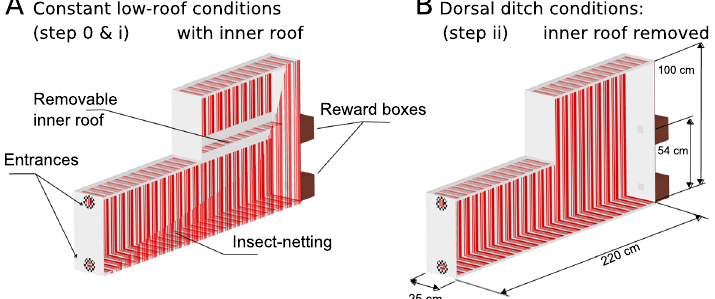
Figure 3. Perspective view of the double-roofed flight tunnel. The floor, roof and left wall of the flight tunnel consisted of planks with red and white stripes oriented transversely to the bees’ flight paths. One side of the tunnel consisted of insect netting lined with stripes formed by a red gelatin filter. The 25 cm-wide and 220 cm- long tunnel consisted of two parts: (i) the first half had a permanent 54-cm low roof, and (ii) the second half had a double roof consisting of a removable inner part set at a height of 54 cm and a permanent upper part set at a height of 1 m. ( A ) Under constant low roof conditions, the inner roof was set at the height (54 cm): the tunnel is therefore endowed with an uniform height of 54 cm. ( B ) Under “dorsal ditch” conditions, this inner roof was removed to make the 1-m high upper roof visible to the honeybees, thus imposing a sudden perturbation on their dorsal visual stimuli. Honeybees were trained to enter the tunnel under constant low roof conditions near either the roof or the floor, depending on the experiment, and they were able to collect a sugar solution reward placed in a box at the end of the tunnel either near the roof or near the floor,